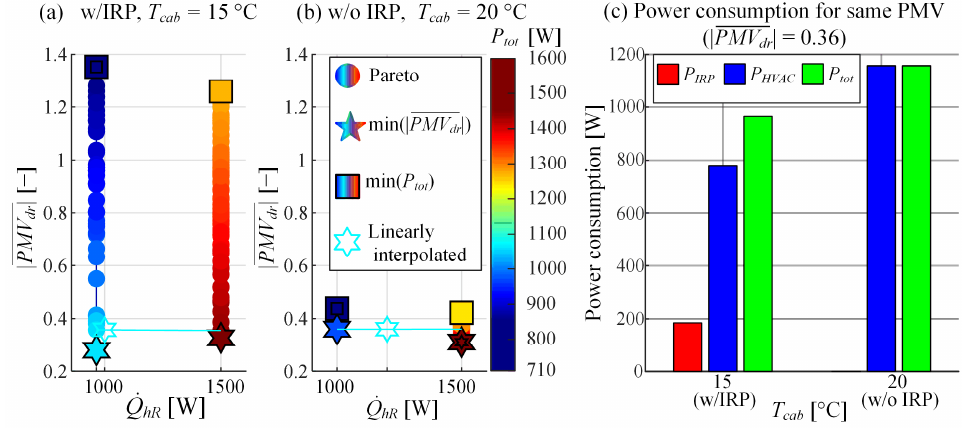
Figure 9. Power consumption reduction analysis ( c ) based on optimisation results ( a , b ) for the same thermal comfort level and different cabin air temperatures under steady-state conditions.